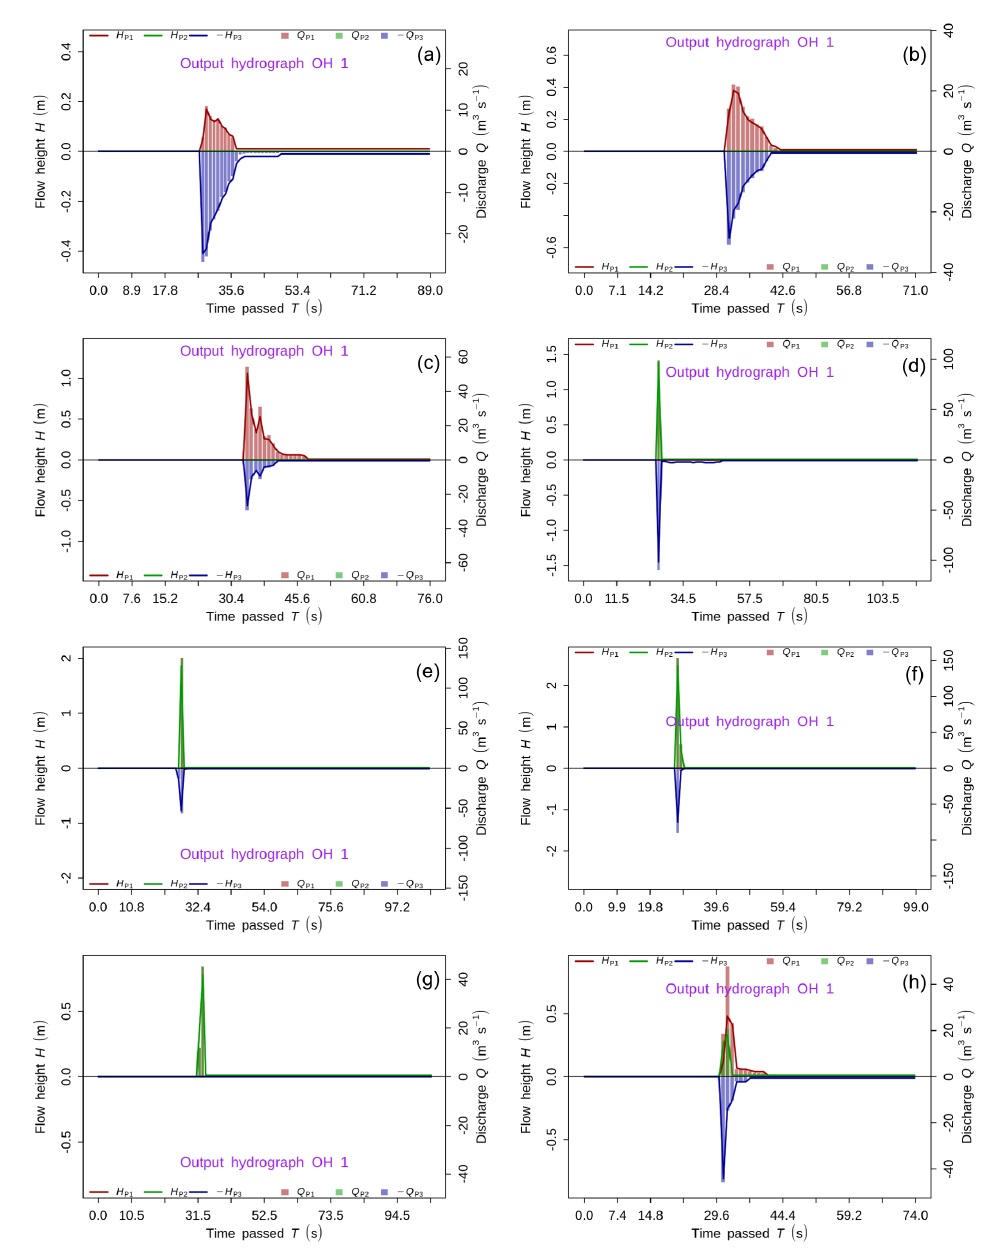
Figure 5. Flow discharge and height profile at 500 m from initial release for ( a ) D3; ( b ) D5; ( c ) D7; ( d ) M3; ( e ) M5; ( f ) M7; ( g ) E1; ( h ) C1. The solid line represents the flow height and the bar chart the